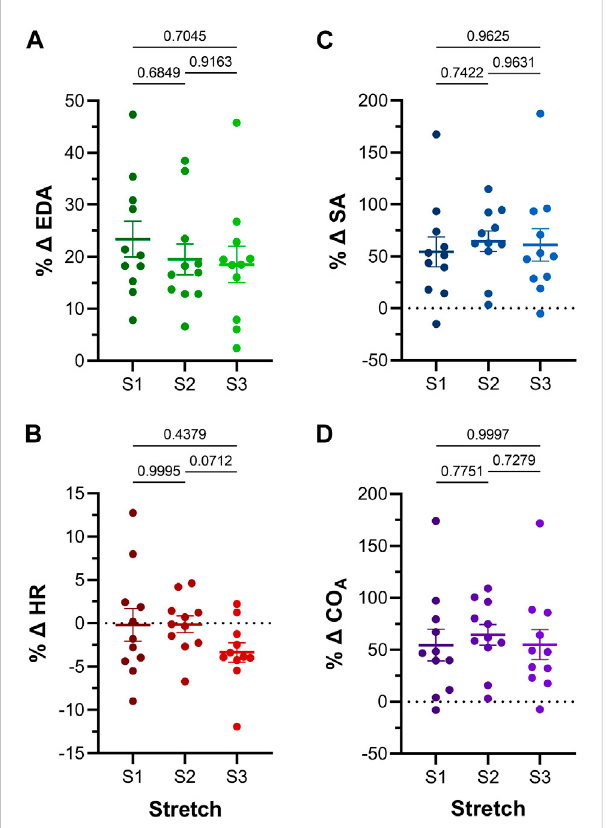
FIGURE 5 Effect of repeated atrial preload application on functional parameters in 48hpf zebra fi sh larvae. Percentage change (% Δ ) of atrial (A) end-diastolic area (EDA), (B) heart rate (HR), (C) stroke area (SA), and (D) output (CO A ) for each period of load application (S1, S2, S3). Average valuespresented as mean ± SEM. Means for each loading period were compared by repeated measures ANOVA, with Tukey post hoc tests for pairwise comparisons. n = 11 larvae.